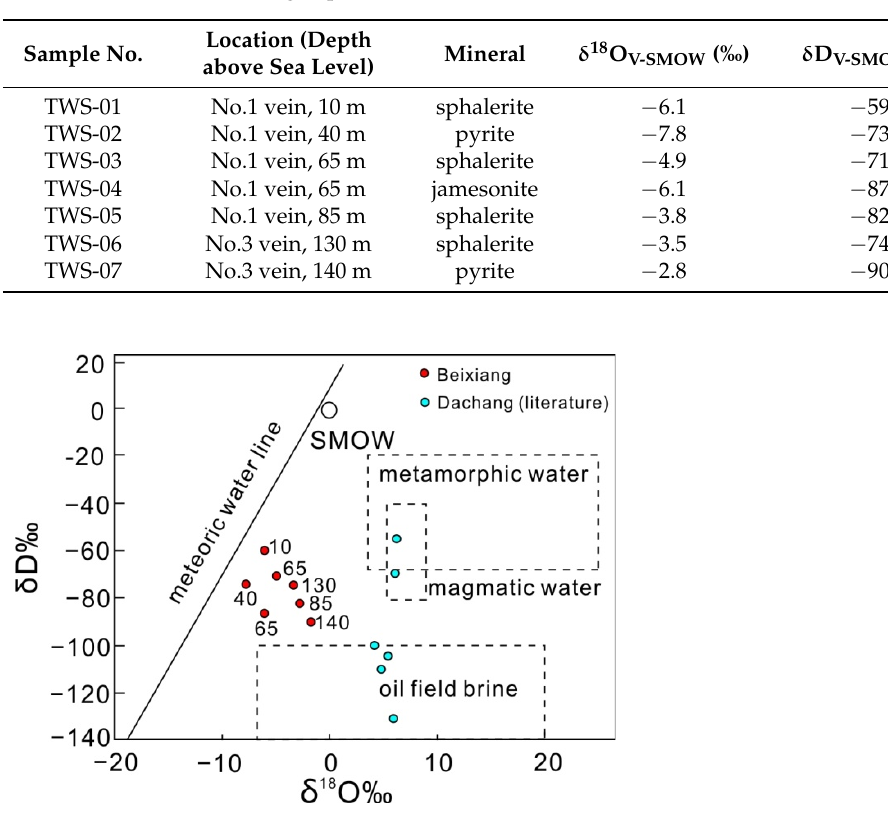
Table 3. Sulfur isotopic compositions of the Beixiang